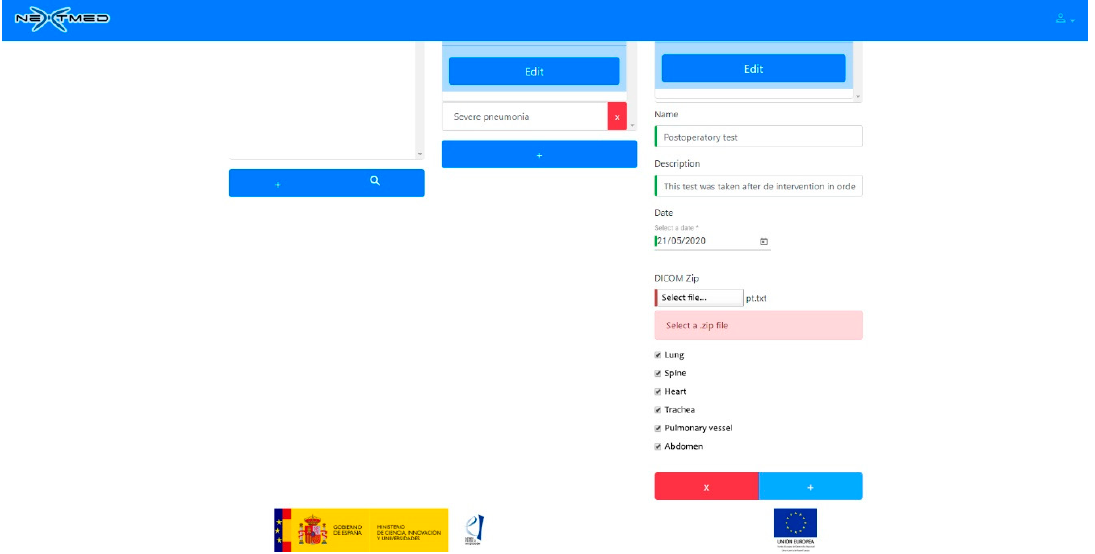
Sensors 2020 , 20 , x FOR PEER REVIEW Figure 17. Web application to manage dicom images for different patients (patient data are not real). Figure 17. Web application to manage dicom images for di